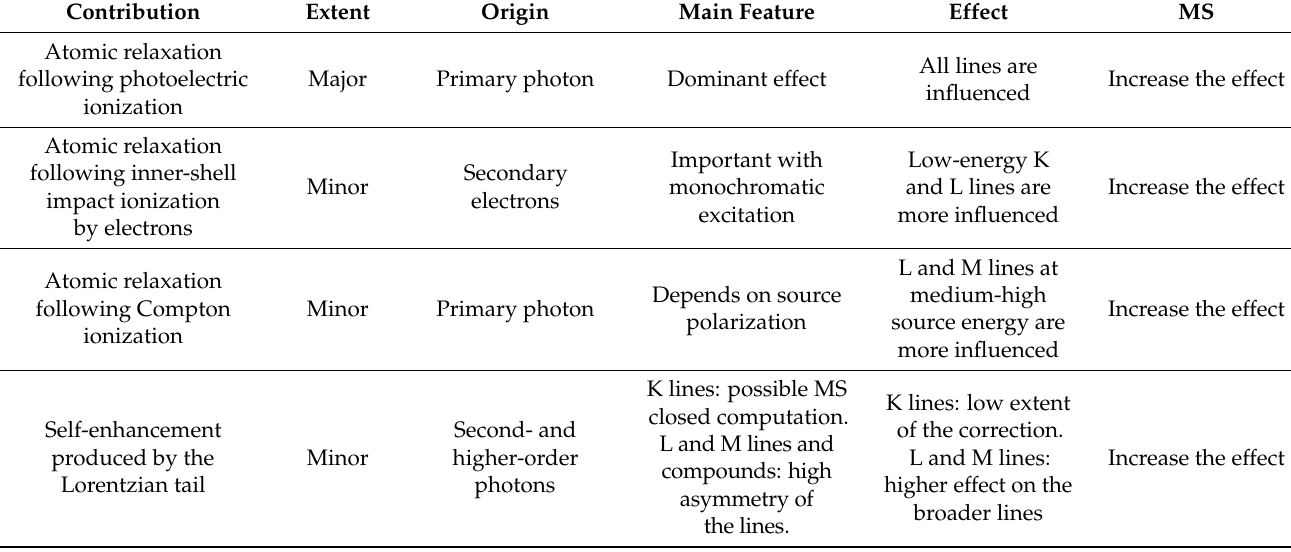
Table 1. Contributions to the characteristic lines described in this